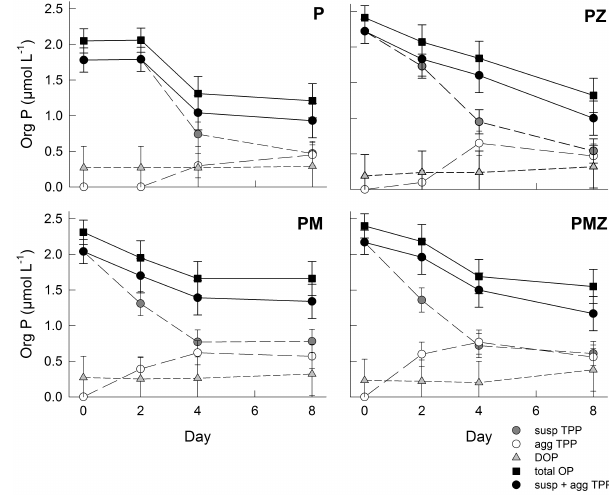
Fig. 3. Concentrations of DOP, total TPP, suspended TPP, and TPP in aggregates in the 4 treatments during the experiment.